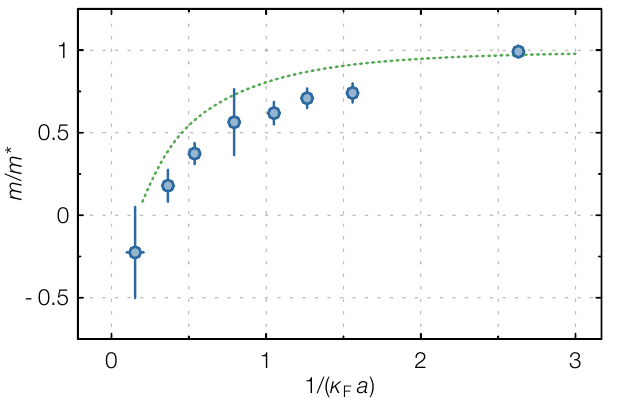
Figure 4. Effective mass of the repulsive Fermi polaron in the equal-mass case: experimental results (blue circles) and theoretical results from a T -matrix approach (dotted green line) [77]. Experimentally, m ∗ is observed to diverge and to even turn negative when approaching the unitary limit, compatibly with a thermodynamic instability of the repulsive polaron Fermi liquid [102,104] at strong coupling. The remaining deviation between theory and experimental data may result from higher-order particle- hole excitations not taken into account in the calculation, as well as from weak polaron–polaron interactions which are neglected in the experimental extraction of m / m *. The figure is adapted from Ref.